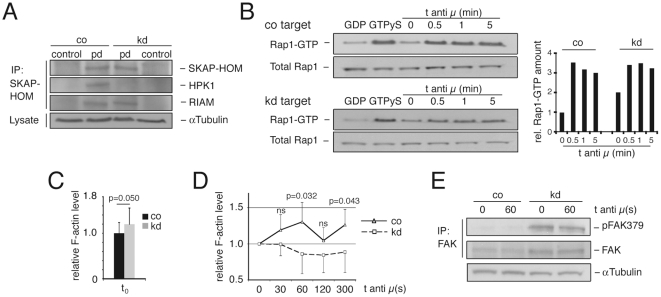
HPK1 associates with SKAP-HOM and negatively regulates Rap1 activation.(A) SKAP-HOM was immunoprecipitated in unstimulated Wehi 231 co/kd cells and pulldowns were detected for SKAP-HOM, HPK1 and RIAM expression by Western blotting; plots are representative for four independent experiments. (B) Left: Active Rap1-GTP of untreated and anti-IgM F(ab')2 (anti µ) stimulated co and kd cells was pulled down with Ral GDS RBD agarose and analysed together with total Rap1 levels by anti-Rap1 Western blotting; quantification of band intensities was performed by normalizing total Rap1 levels of lysates by densitometric evaluation (ImageJ) and all time points of Rap1-GTP samples were compared to the control target at t0 = 1; GDP/GTP: negative/positive control; right: graph representative for three independently performed experiments. (C) F-actin levels (means ± SD; Student's t; n = 6) of untreated co and kd cells measured by Phalloidin-FITC flow cytometric staining. (D) F-actin levels (means ± SD; Student's t; n = 6) of anti-IgM F(ab')2 (anti µ) stimulated co and kd cells. (E) Untreated and anti-IgM stimulated FAK immunoprecipitates of Wehi 231 co and kd cells were detected for total FAK and pFAK379 expression by Western blotting (n = 3); ns, not significant; pd, pulldown.